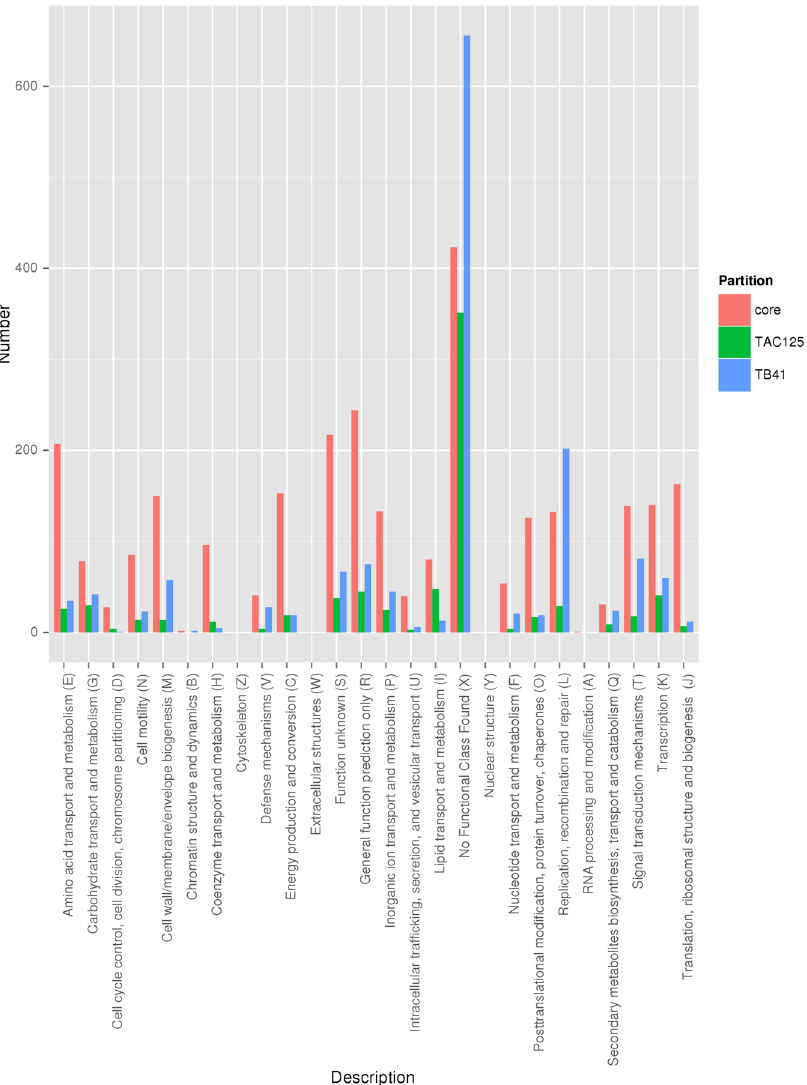
Figure 1. Frequency (%) of the core and specific genes associated to COG categories in the Antarctic bacteria PhTAC125 and PspTB41 based on genomic data. COG functional categories: RNA processing and modification (A); Chromatin structure and dynamics (B); Energy production and conversion (C); Cell cycle control, cell division, chromosome partitioning (D); Amino acid transport and metabolism (E); Nucleotide transport and metabolism (F); Carbohydrate transport and metabolism (G); Coenzyme transport and metabolism (H); Lipid transport and metabolism (I); Translation, ribosomal structure and biogenesis (J); Transcription (K); Replication, recombination and repair (L); Cell wall/membrane/envelope biogenesis (M); Cell motility (N); Posttranslational modification, protein turnover, chaperones (O); Inorganic ion transport and metabolism (P); Secondary metabolites biosynthesis, transport and catabolism (Q); General function prediction only (R); Function unknown (S); Signal transduction mechanisms (T); Intracellular trafficking, secretion, and vesicular transport (U); Defense mechanisms (V); Extracellular structures (W); No Functional Class Found (X); Nuclear structure (Y); Cytoskeleton